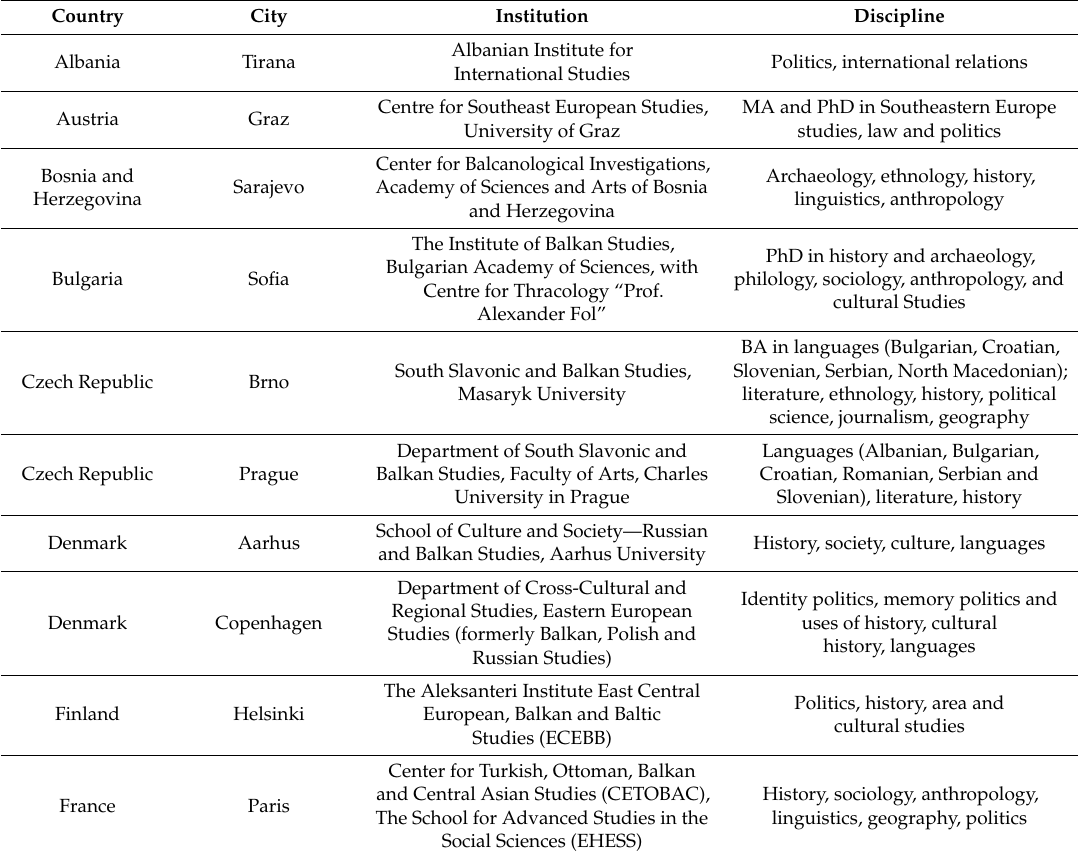
Table 1. Balkan Studies at universities and institutes